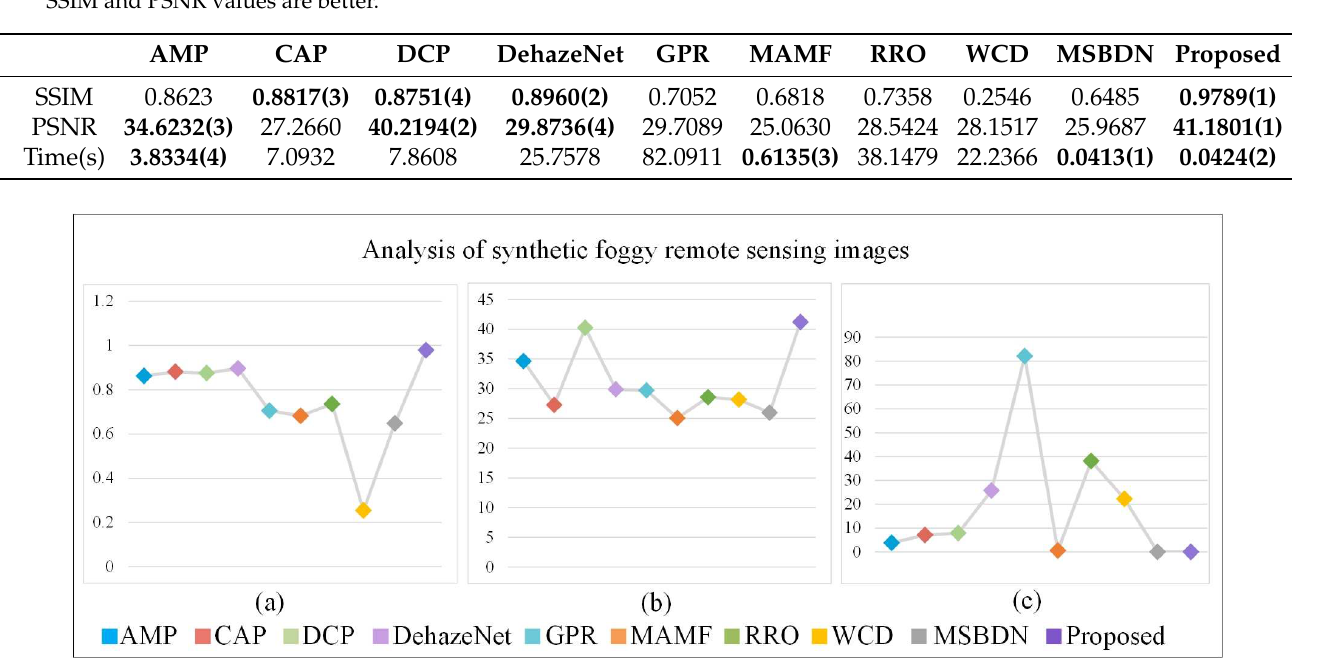
Figure 12. Analysis of ten image defogging methods in synthetic foggy remote sensing scenes, ( a ) SSIM, ( b ) PSNR, ( c ) processing time.